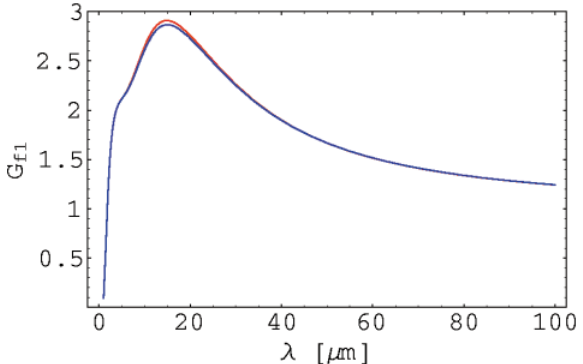
FIG. 1. (Color) BC1 gain G f 1 of the density modulation as a function of modulation wavelength at the exit of BC1 as calcu- lated from Eq. (38) with (in red) and without (in blue) the last term (the two-stage amplification).